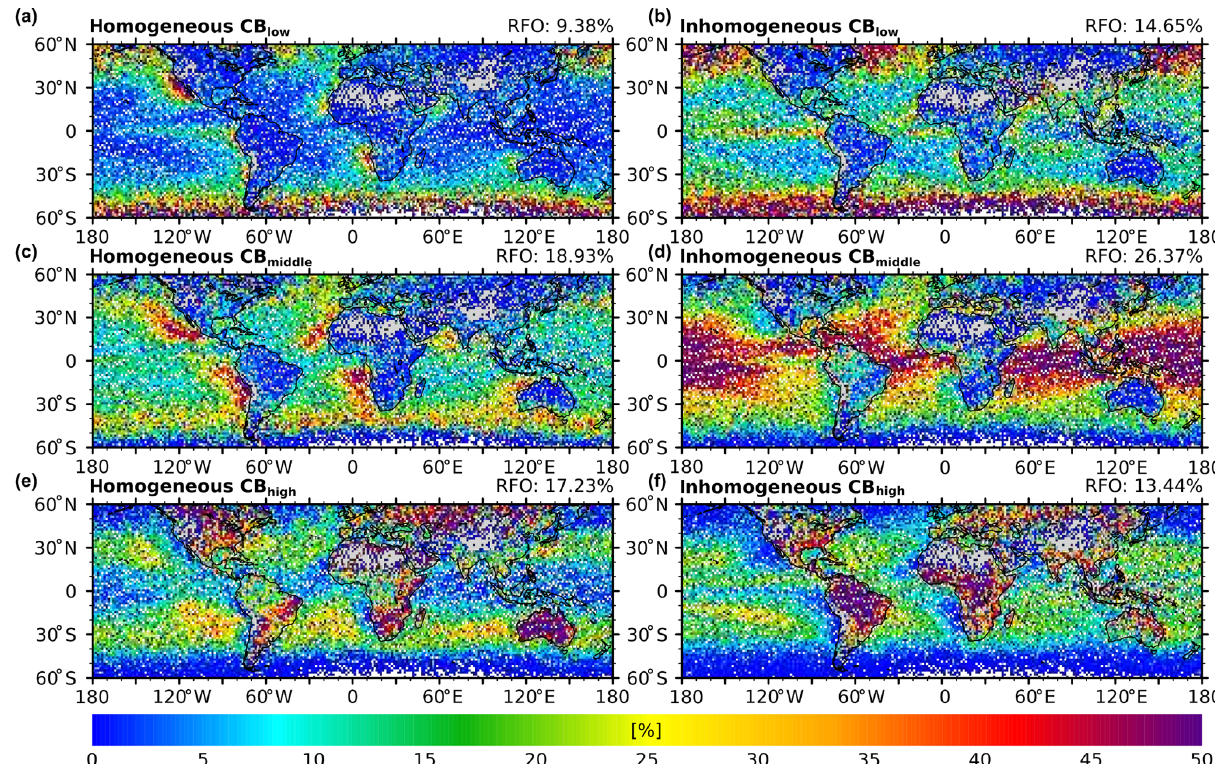
Figure 3. Relative frequency of occurrence of the six cloud classes separated using the three classes of cloud-base height and two classes of cloud-top height heterogeneity. (a, b) Low, (c, d) mid-latitudes and (e, f) high clouds and (a, c, e) homogeneous (stratiform) and (b, d, f) heterogeneous (cumuliform) clouds.